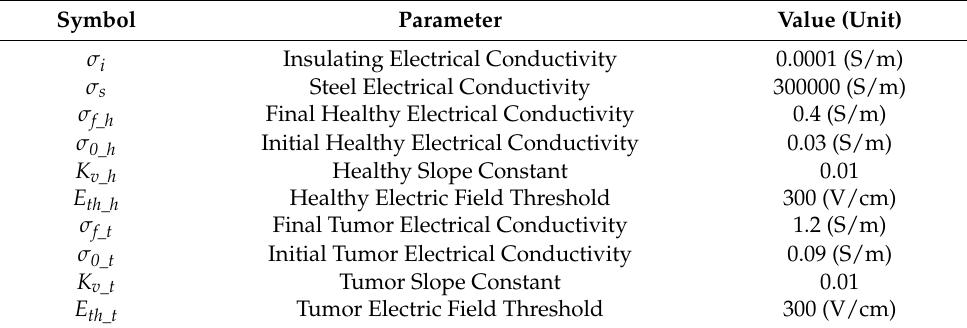
Table 1. Model parameters extracted from